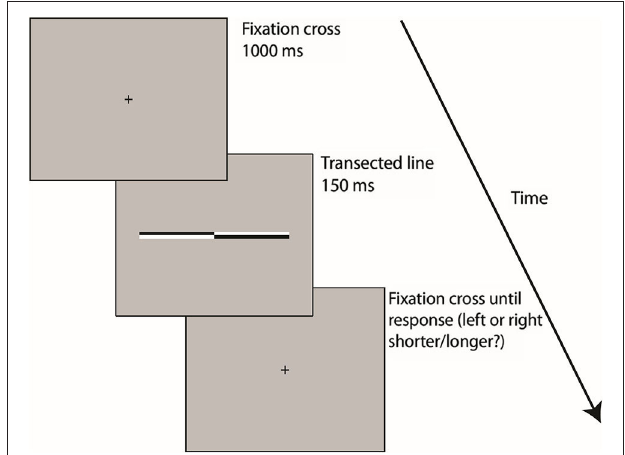
FIGURE 2 | A schematic representation of the trial procedure . Following 1000 ms presentation of a fixation cross, transected lines were presented for 150 ms before reappearance of the fixation cross on the screen until the subject responded, by pressing either the left or right (shorter/longer?) response key. The subsequent trial began as soon as the response was made.